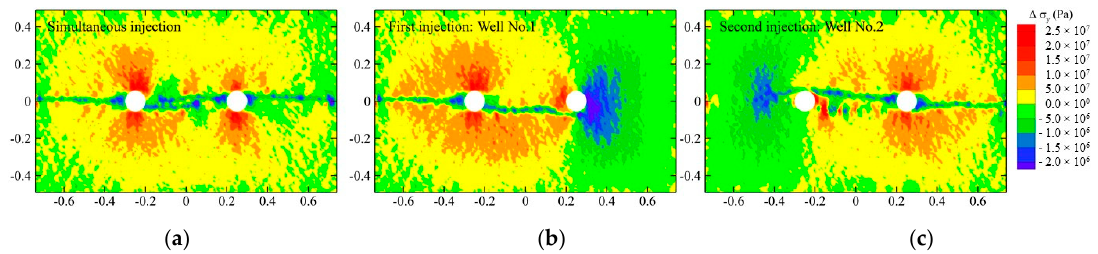
Figure 17. Vertical stress increment distributions for the two-well granite model with the well spacing of 0.5 m under different injection sequences when σ v = 15 MPa and σ h = 30 MPa: ( a ) simultaneous fracturing; ( b ) first injection in Well No.1; and ( c ) second injection in Well No.2.